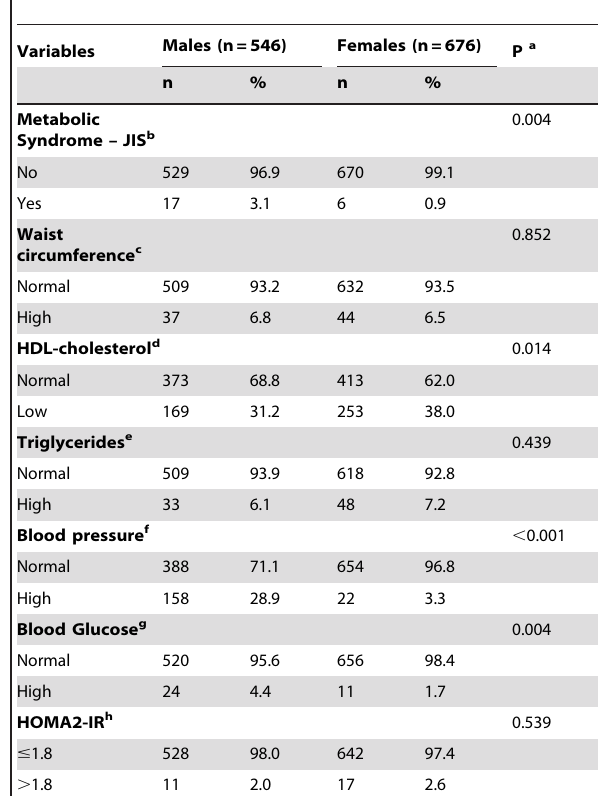
Table 1. Prevalences of metabolic syndrome, its components and insulin resistance by sex among young adults with